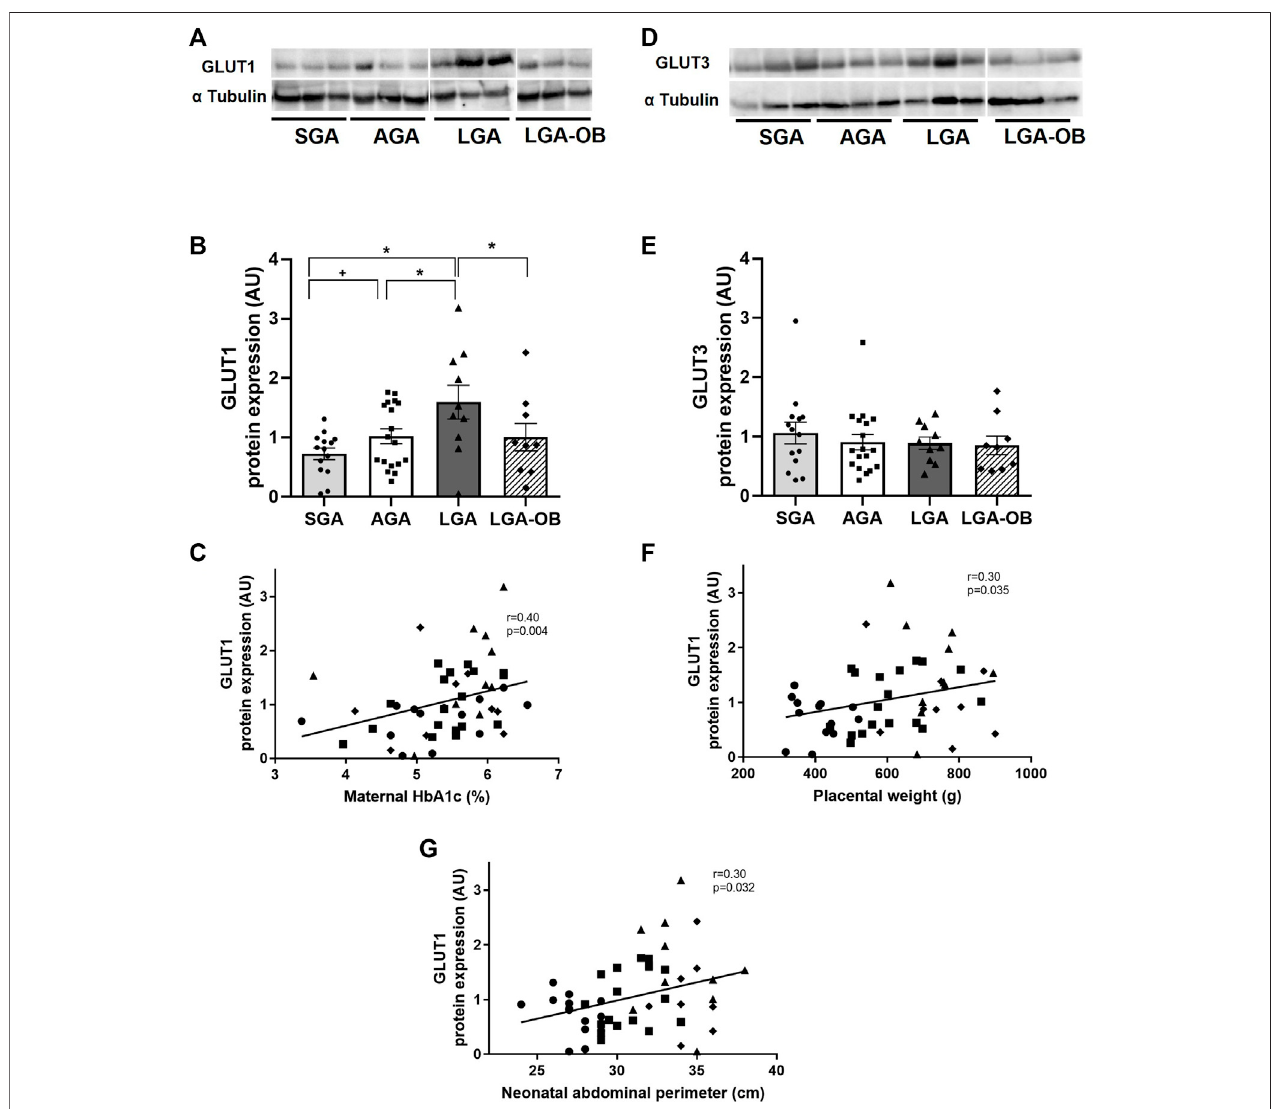
FIGURE 1 | Protein expression of glucose transporters in placentas of SGA, AGA, LGA, and LGA-OB newborns. Representative Western blot of GLUT1 (A) and GLUT3 (D) inplacentasofSGA(n=14),AGA(n=18),LGA(n=10),andLGA-OB(n=9)newborns.Bandspresentedcorrespondtothesamemembrane.Quanti fi cation ofGLUT1 (B) andGLUT3 (E) proteinexpressionsintheplacentabyimmunodetection.Dataaremean±SE.*denotessigni fi cantdifference( p < 0.05)betweengroupsby ANOVA.+denotes signi fi cantdifference whencompared tocontrolAGAbyStudent´s t test. Correlation betweentheplacentalexpression ofGLUT1withmaternal HbA1c (C) , placental weight (F), and neonatal abdominal perimeter (G) .